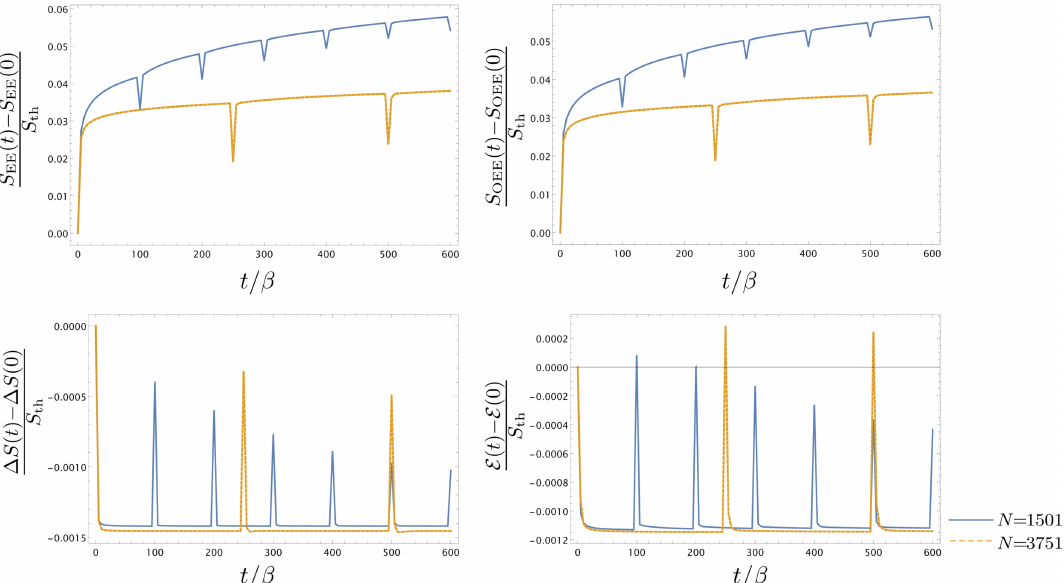
Figure 4 . Decompactification limit: the dynamics of S EE , S OEE , ∆ S = S OEE − S EE and E (sub- tracted from the initial values and normalized with thermal entropy) extrapolated from circle to a line with fixed lattice spacing δ and mβ =10 − 5 . The blue curve denotes the theory on a circle with the total number of sites N =1501 and N = N + N =2+20 . The dashed-orange A L ( R ) A L 1( R 1) A L 2( R 2) curve represents the same theory on a circle with fixing δ and increasing the total number of sites (and accordingly subsystem sites) to N =3751 . Increasing N causes the effects of finite size to be transferred to larger times. We also observe the logarithmic growth at the intermediate